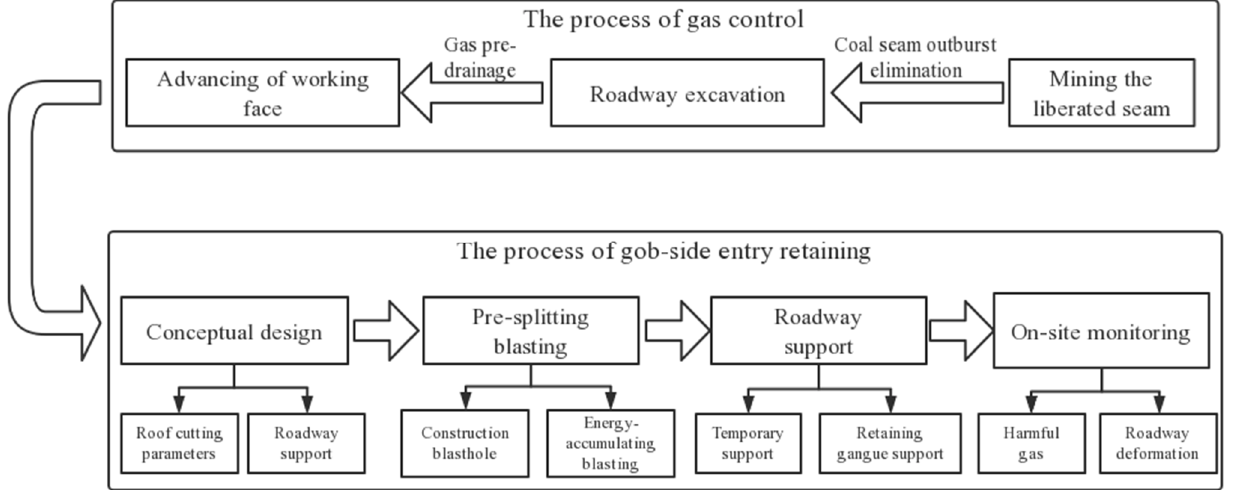
Figure 12. Whole process of gob-side entry retention in a high gas outburst coal seam.